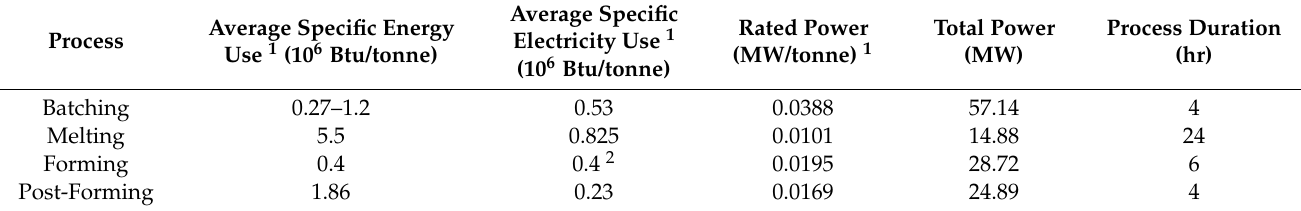
Table 9. The glass container industry load curves in Shams Abad (full-load assumption).